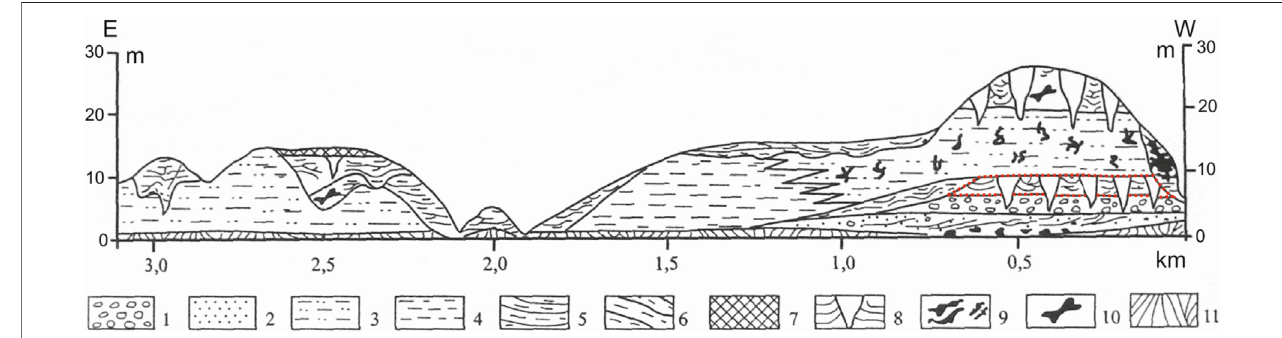
FIGURE3| Structure oftheQuaternarydepositssection 7.5 kmeast ofCapeSvyatoy Nos(ascitedinNikolsky and Basilyan,2004).TheYukagirSuite isindicated bythereddottedoutline.Legend:1 – gravelwithsandandloamlayers;2 — obliquesandswithcasts;3 — thinlayeredloamysandswithgrassrootlets;4 – morealeuriticthin layered loamy sands; 5 — aleurites with ice wedges; 6 — Pleistocene and Holocene alas complexes; 7 — peat; 8 — ice wedges; 9 — woody remains; 10 — remains of large mammals; 11 —